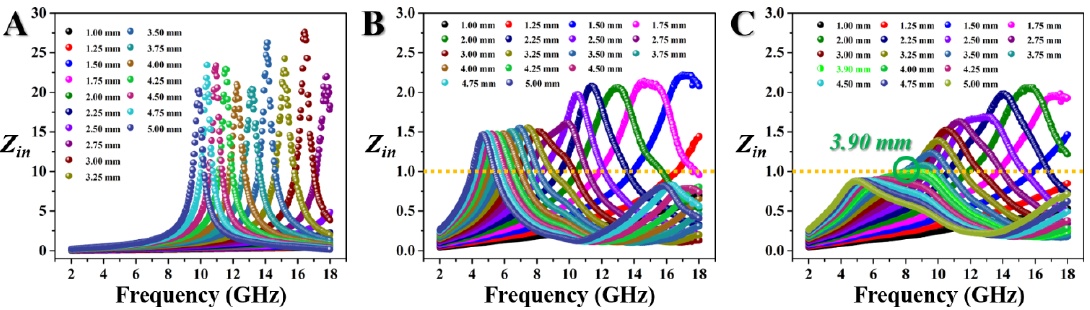
Figure 10. The calculated Z in values for ( A ) MF, ( B ) CMF and ( C ) MCMF.